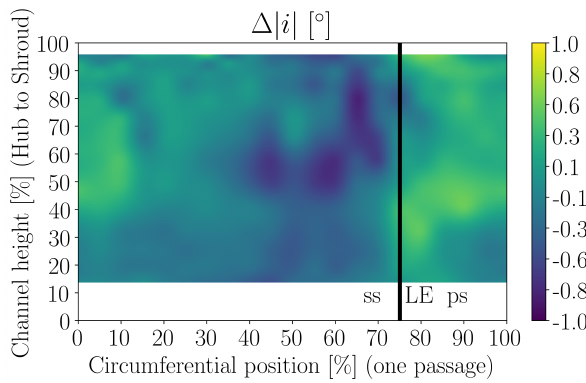
Figure 8. Baseline diffuser’s α angle distribution near stability limit at Mu 2 = 1.16.